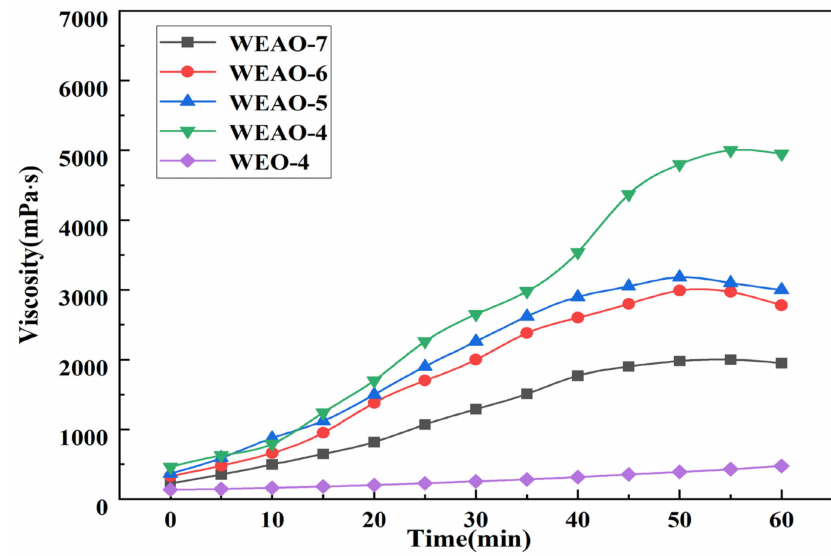
Figure 7. Viscosity of WEO and WEREA modified by oxidized extraction oil.